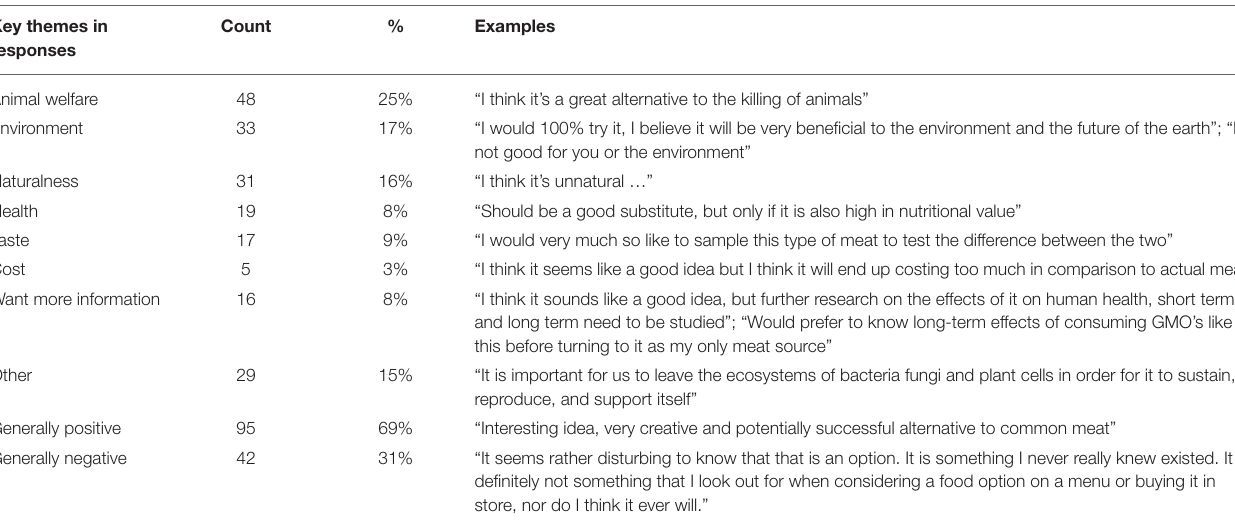
TABLE 1 | Key themes from the open response question “What is your opinion about the consumption of cultured meat?” Key themes in